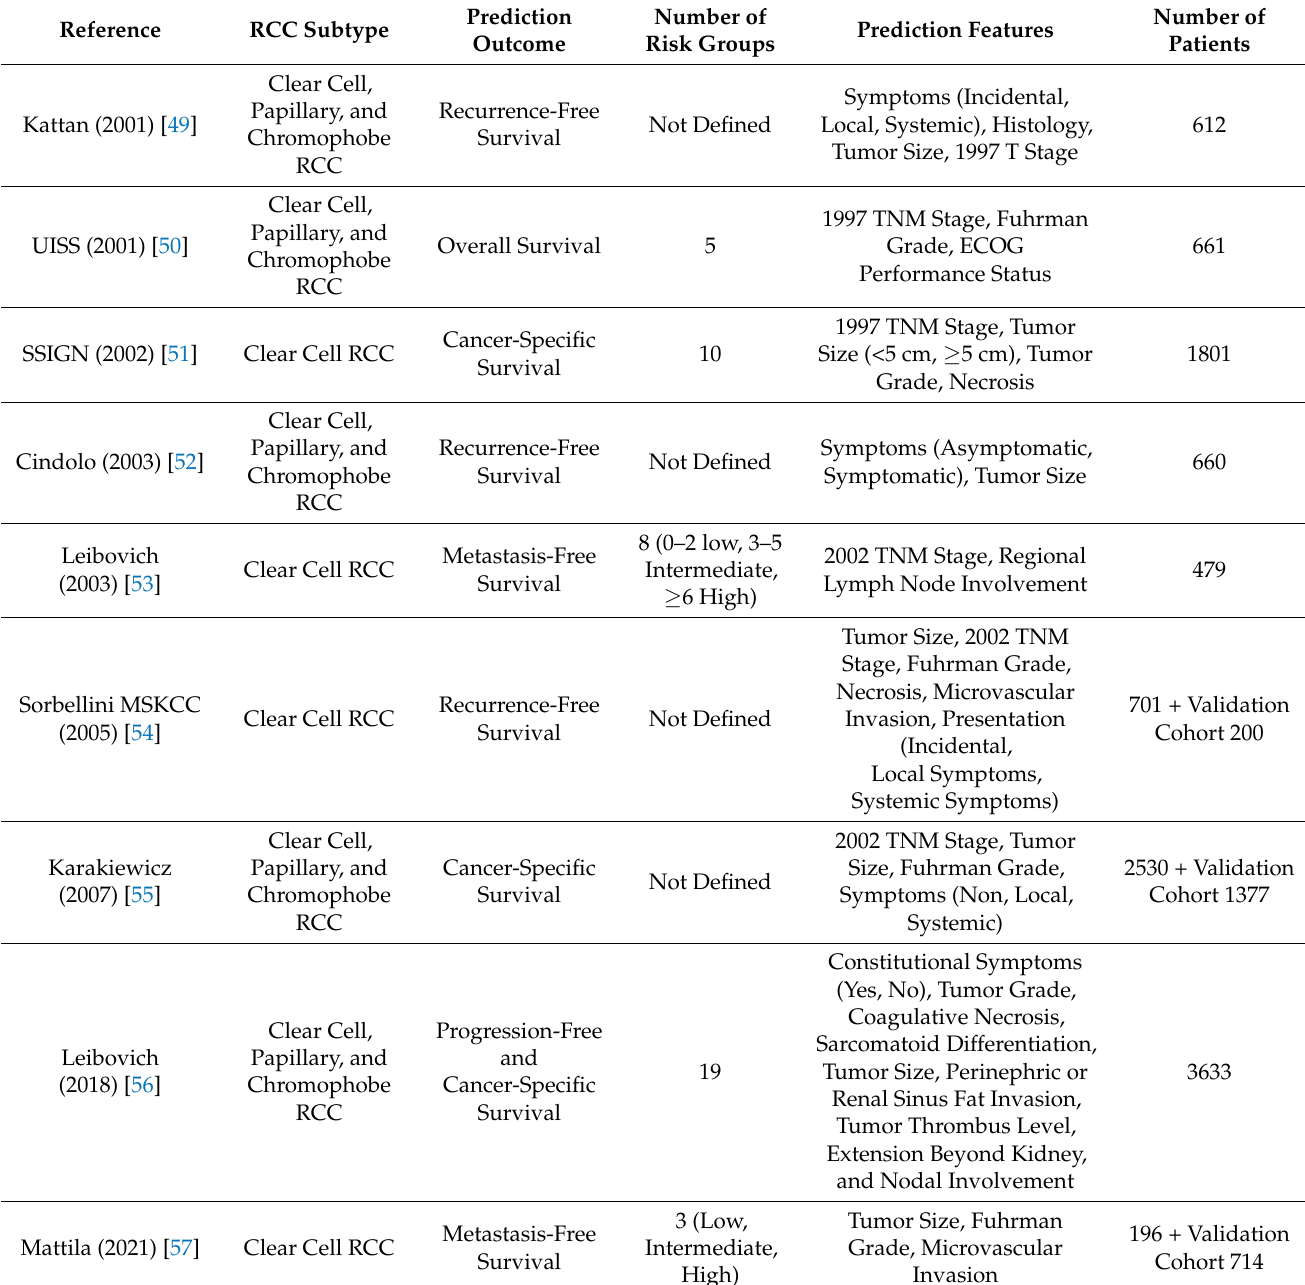
Table 1. Postoperative prognostic models for localized